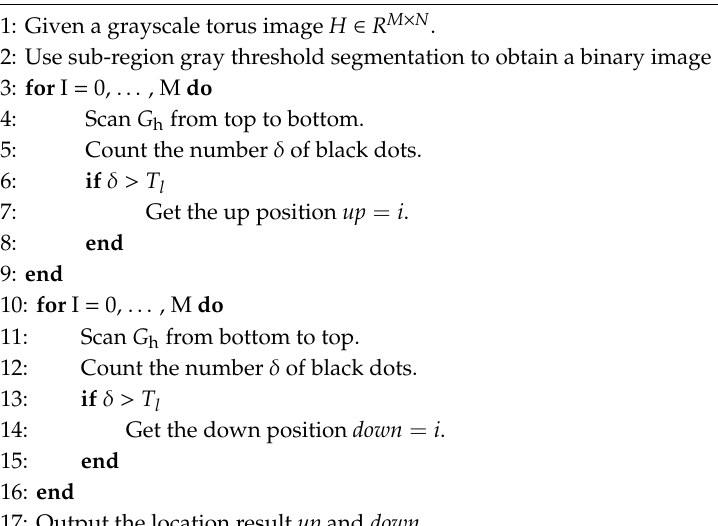
Figure 8. Torus image processing: ( a ) annotation of torus images; ( b ) location result; ( c ) original defect image of torus (2056 × 600); ( d ) torus gray binary image; ( e ) edge-removed torus gray binary image; ( f ) torus gradient binary image; ( g ) edge-removed torus gradient binary image; ( h ) Algorithm 1 Magnetic Ring Location Algorithm segmentation of torus images.